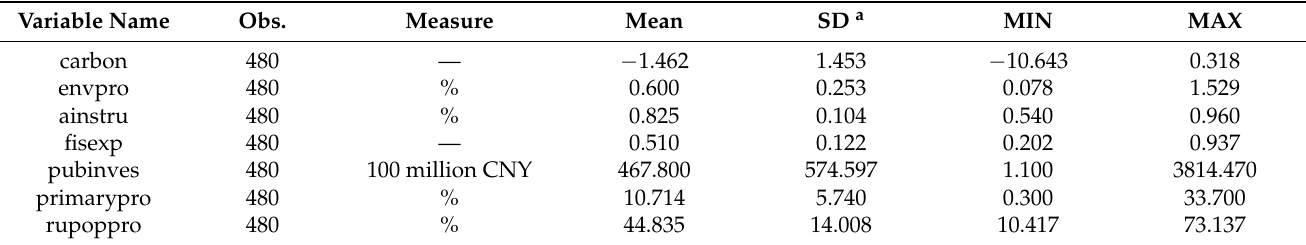
Table 1. Variable description and descriptive